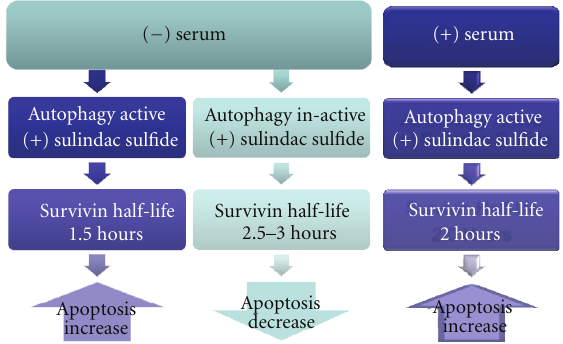
Figure 7: Our model of how autophagy inhibition e ff ects survivin and sulindac sulfide-induced apoptosis in serum-containing and serum-deprived